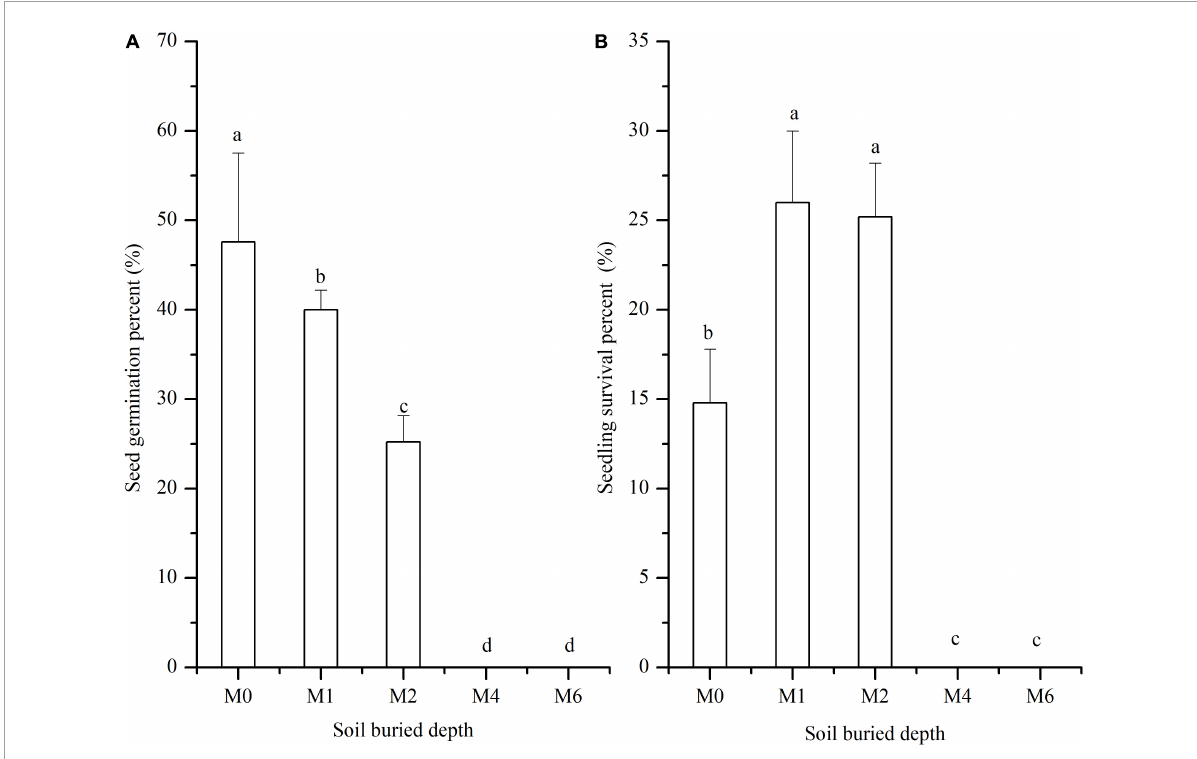
FIGURE1 Seed germination of S. salsa subjected to different soil burial depths. (A) Seed germination percent (%) and (B) seedling survival rate subjected to 0 cm (M0), 1 cm (M1), 2 cm (M2), 4 cm (M4), and 6 cm (M6) buried depths. Different letters indicate significant differences in different buried depth. The data was 0 at M4 and